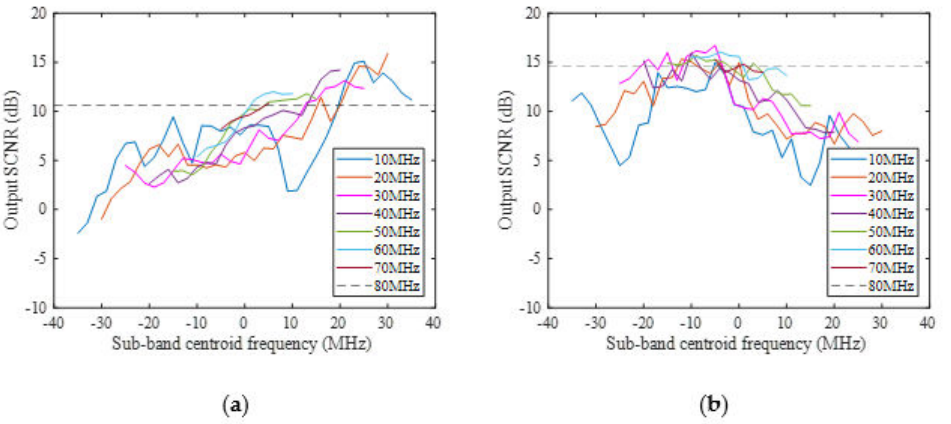
Figure 7. SCNR performance of sub-band STAP with respect to different sub-band distributions ( a ) 1 -th measured data frame based result. ( b ) 2 -th measured data frame based